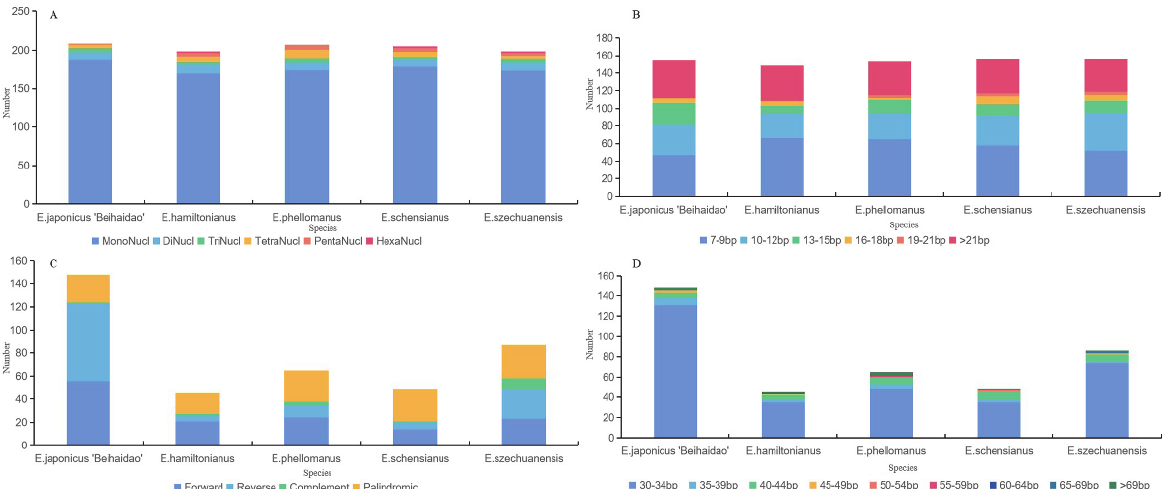
Figure 9. Repeat sequence statistics of Euonymus . ( A ) Type of SSR; ( B ) Length distribution of SSR; ( C ) Type of long repeats; ( D ) Length distribution of long repeats.